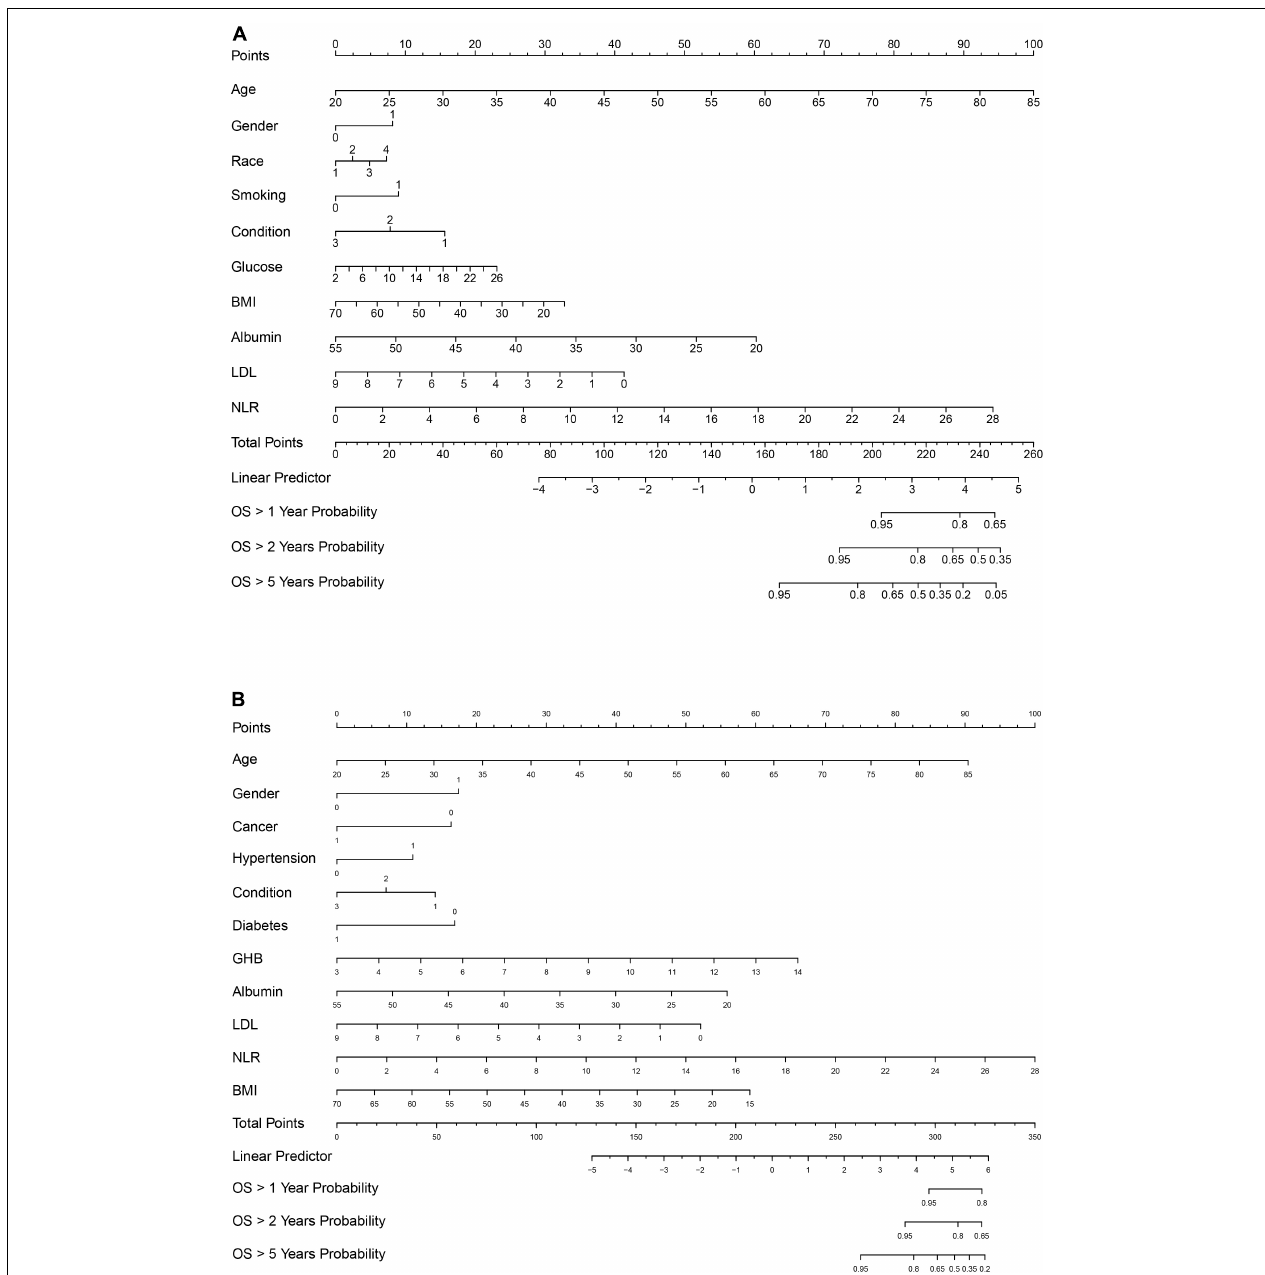
FIGURE 3 | (A) Nomogram model for all-cause mortality. (B) Nomogram model for cardiovascular mortality. Race: 1, Mexican American; 2, other race; 3, non-Hispanic White; 4, non-Hispanic Black. Gender: 1, male; 0, female. For hypertension, diabetes, smoking, and cancer: 1, Yes; 0, No. Condition: recent